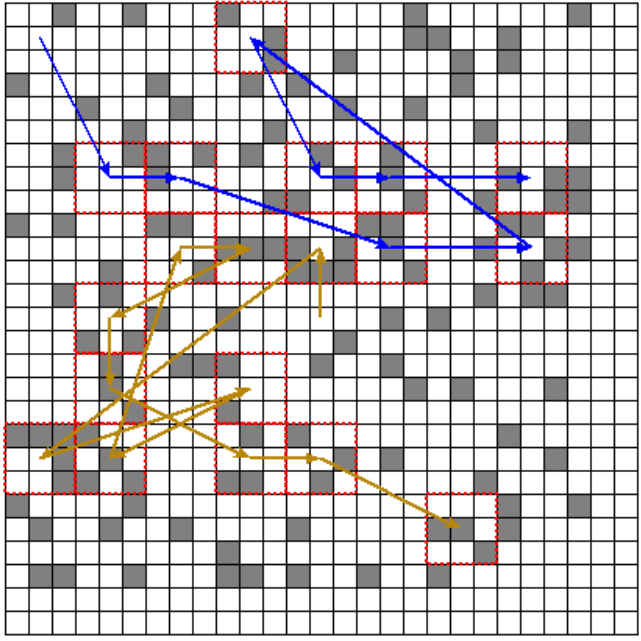
Figure 10. Path of a double node.